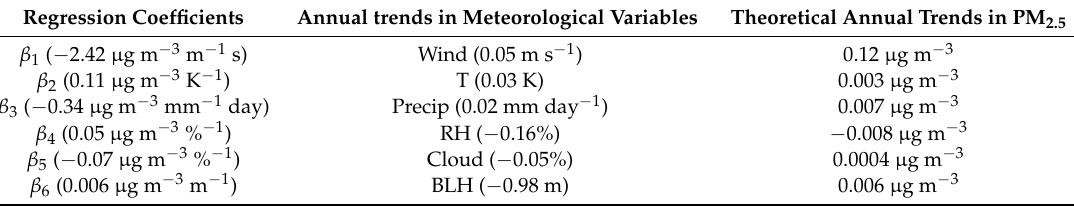
Figure A6. Annual trends in meteorological factors over the YRB from 1980 to 2017. Table A2. Summary of regression coefficients between surface PM 2.5 and meteorological variables, annual trends in meteorological variables and theoretical annual trends in PM 2.5 based on MLR model. β 1 . . . β 6 refer to regression coefficients between PM 2.5 and wind speed (Wind), temperature (T), precipitation (Precip), relative humidity (RH), total cloud cover (Cloud) and Boundary layer height (BLH), respectively.